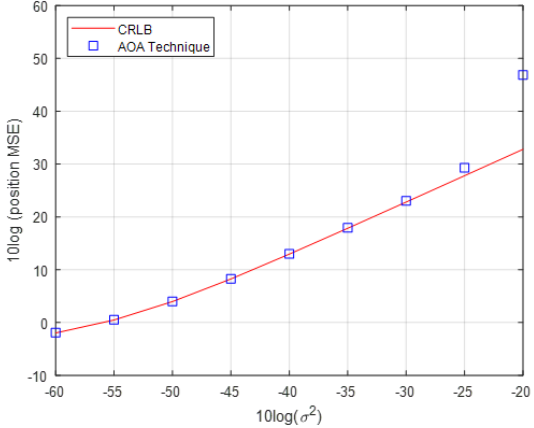
Figure 4. The geometry and Performance validation of the AOA technique. In the simulation scenario, 100 sensor network geometries were considered to achieve the average MSE. The sensors have been divided into 10 groups distributed randomly and centred at [ 0,0,0 ] T . In addition, the emitter position of each sensor was placed randomly in a larger cube centred at [ 0,0,0 ] T with a distance of 500. In addition, the azimuth angle error, elevation angle error and sensor position error were independent [39].